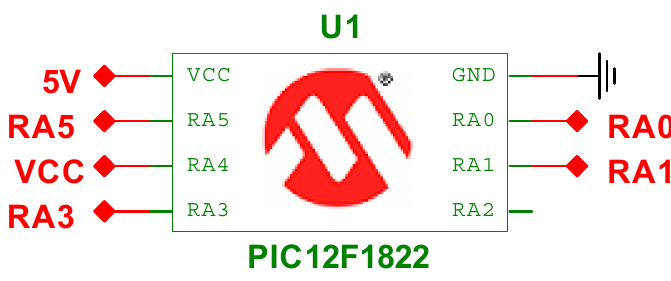
Crystals 2021 , 11 , x FOR PEER REVIEW Figure 11. Microcontroller connections to control charging and discharging of capacitors.